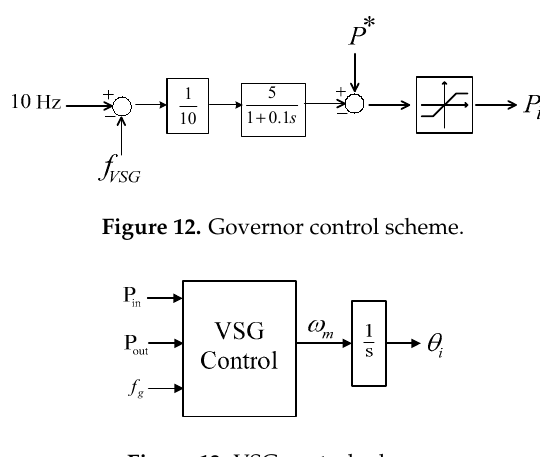
Figure 11. Flow chart of solving swing equation by Runge–Kutta method.